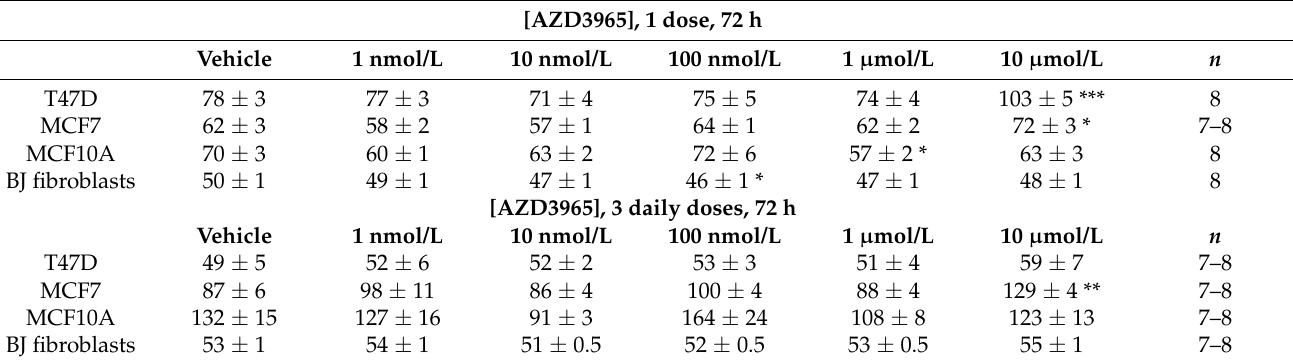
Figure 6. AZD3965 is not cytotoxic for proliferative breast-associated cells when glucose and glutamine are available as metabolic fuels. ( A ) Density of T47D, MCF7, MCF10A cells and BJ fibroblasts over time when cultured in medium containing 25 mmol/L glucose with 10 mmol/L GlutaMAX, 10% FBS and without added lactate ( white circles ) or in medium containing 10 mmol/L sodium L -lactate, no glucose, no glutamine and 1% FBS (black circles) ( n = 8–16). ( B , C ) Cell density was assayed in medium containing 25 mmol/L glucose with 10 mmol/L GlutaMAX, 10% FBS and without added lactate. ( B ) Cell density over time after a single treatment (arrow) with vehicle or different doses of AZD3965 ( n = 8). ( C ) Cell density over time upon daily treatments (arrows) with vehicle or a given dose of AZD3965 ( n = 7–8). All data are shown as means ± SEM. *** p < 0.005 comparing whole curves using two-way ANOVA ( A ). Analysis of cell proliferation ( B , C ) is presented in Table 2. Table 2. Cell doubling times (h) in medium containing 25 mmol/L glucose, 10 mmol/L GlutaMAX and 10% FBS ± AZD3965.